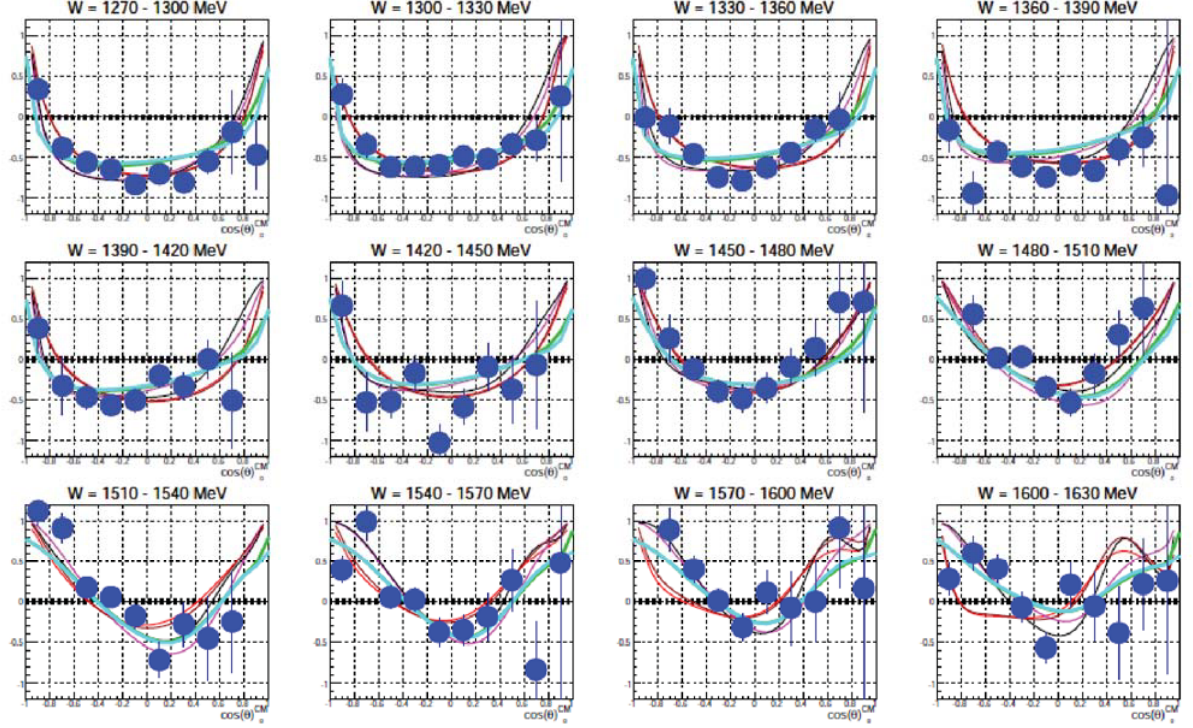
Figure 8. Results for the double polarisation observable E for the photoproduction channel γ n → π 0 n , as a function of cos θ CM selected 30 MeV energy bins, for quasi-free (blue circles) neutrons [20]. The results are compared to the Bonn-Gatchina free neutron model [21], without (dark red line) and with (red line) Fermi motion contribution (IA), SAID-CM12 [22] (black line), MAID [14] (magenta line), MAID + IA (cyan line), MAID + IA + FSI [15] (green line) partial wave solutions.